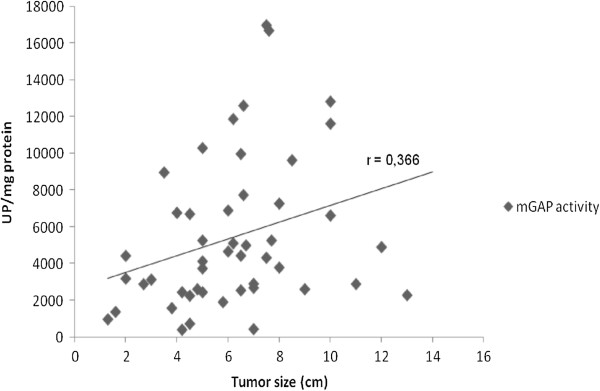
Representation of the correlation between membrane-bound gultamyl-aminopeptidase and tumour size in CCRCC. Values represent mean ± SE of enzyme activities recorded as units of enzyme per milligram of protein (U/mg prot). Spearman’s rank test: coefficient (r) = 0.366; P < 0.05.